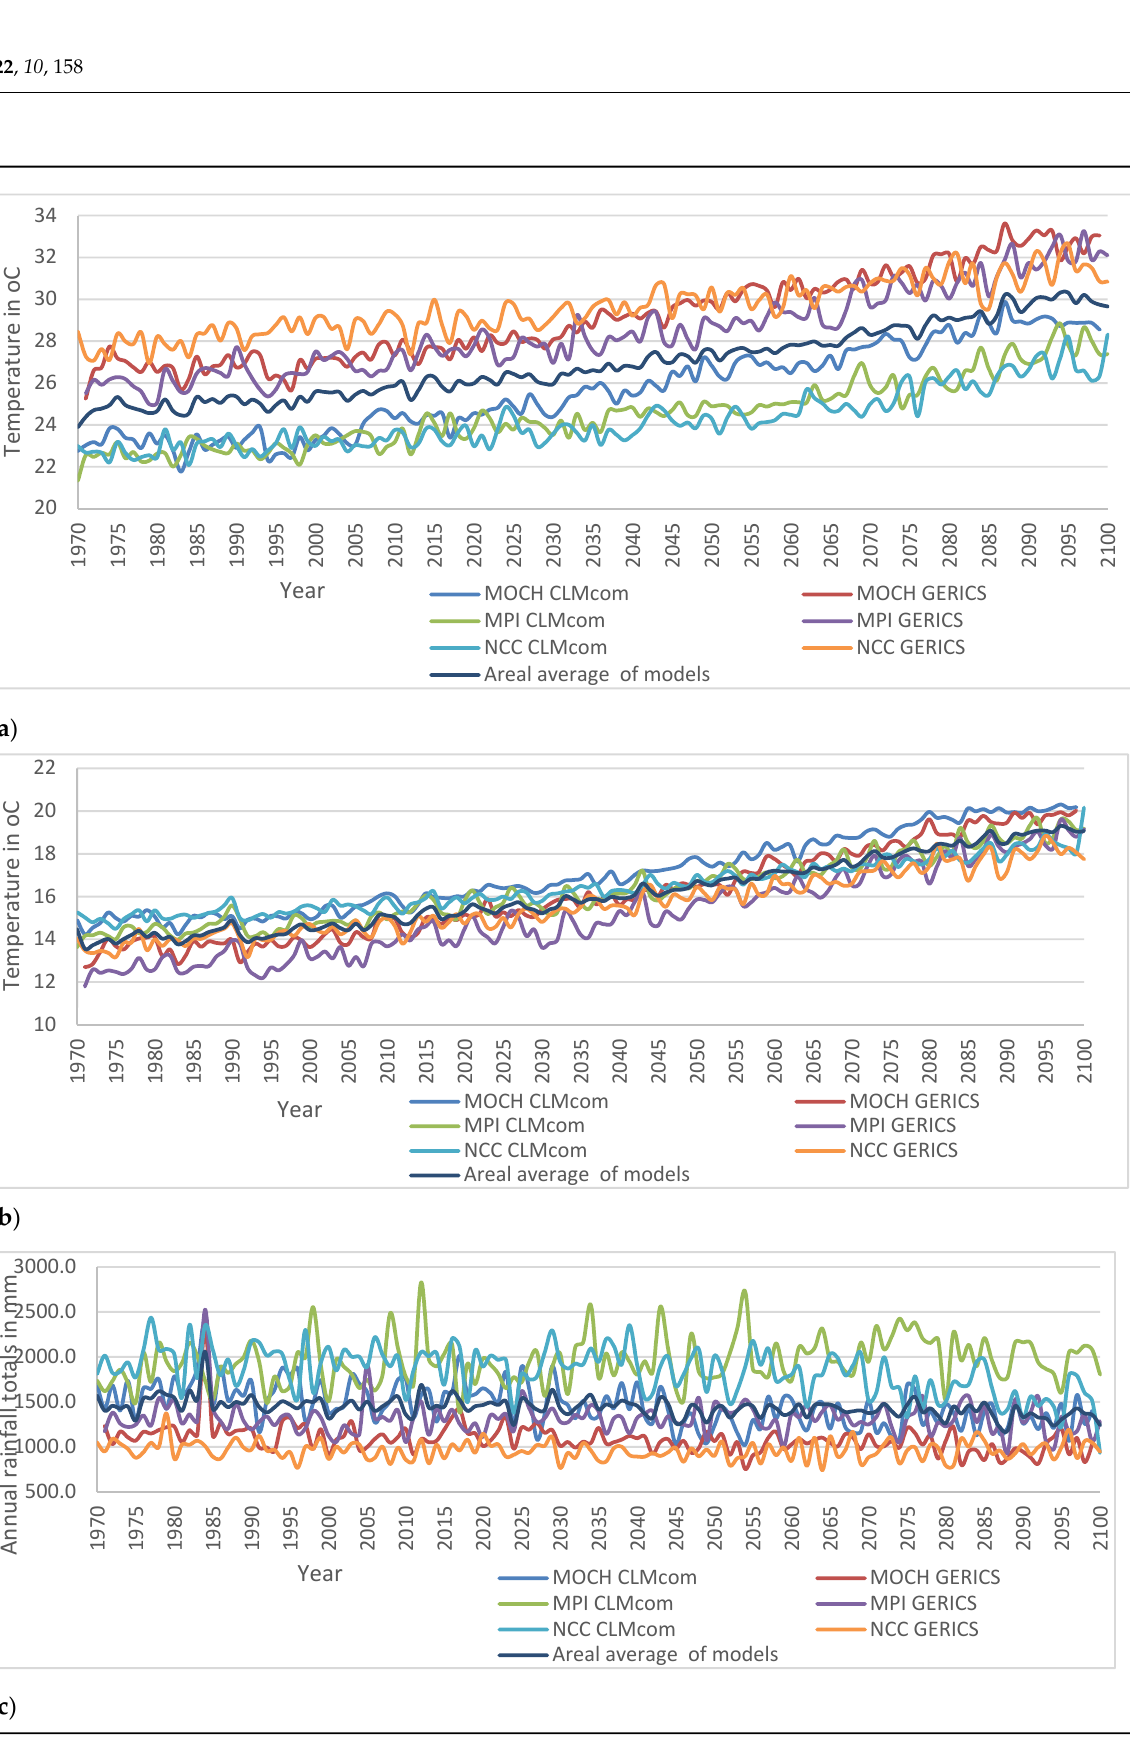
Figure 2. Time series showing the model simulations and projections of climate data for the historical (1970–2005) and projected (2006–2100) periods over the southwest urban centers of Ethiopia: ( a ) maximum temperature; ( b ) minimum temperature; ( c ) annual precipitation totals.